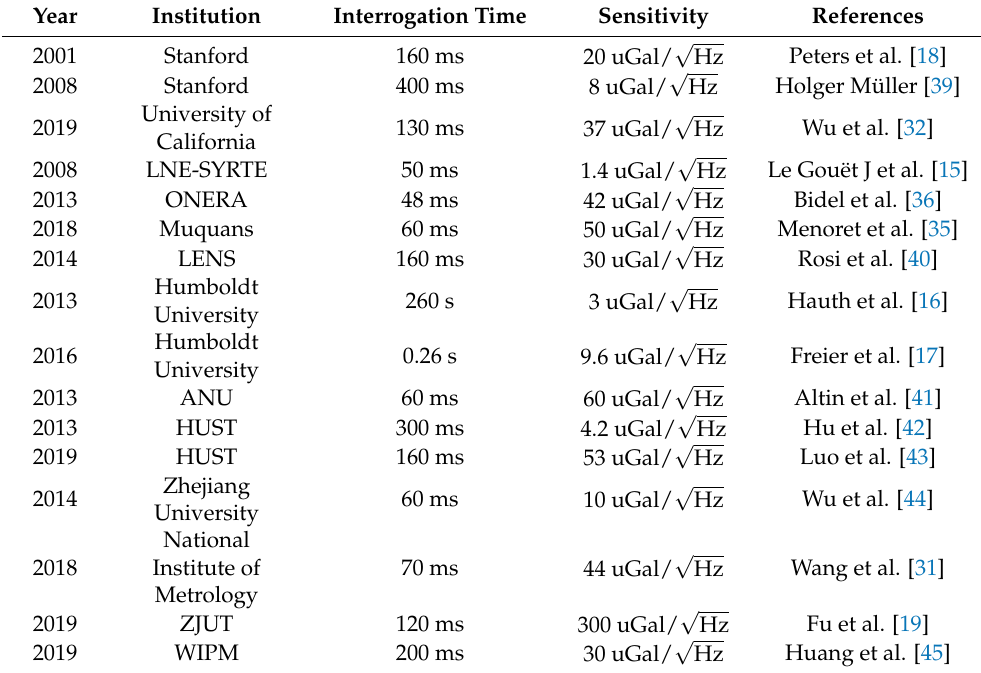
Table 1. Overview of studies on